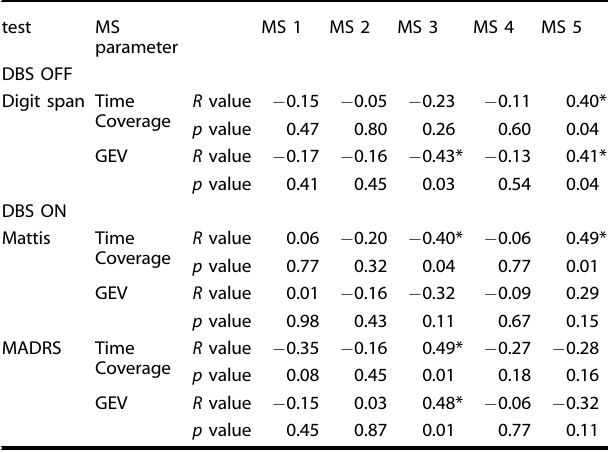
Fig. 3 The signi fi cance of the EEG microstate 4. a - mean beta power during the presence of MS 4 compared across analyzed groups. Each box covers the data from 25th to 75th percentiles; the red line in each box represents the median over subjects in particular group, and whiskers represent 1.5 times the interquartile range (IQR). Red crosses show the outliers. Green lines mark signi fi cant differences ( p < 0.05). b - correlation between GEV and MDS-UPDRS III score (differences between DBS OFF – DBS ON state). c - electrical source imaging of EEG segments where MS 4 was presented (10% highest activations). Table 1. Correlations between EEG microstate parameters and neuropsychological